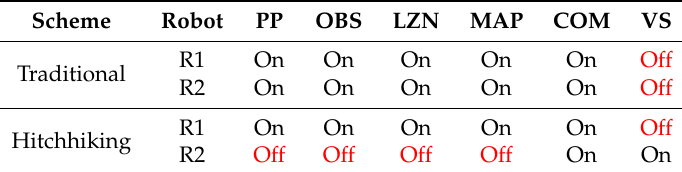
Table 3. Modules run with and without